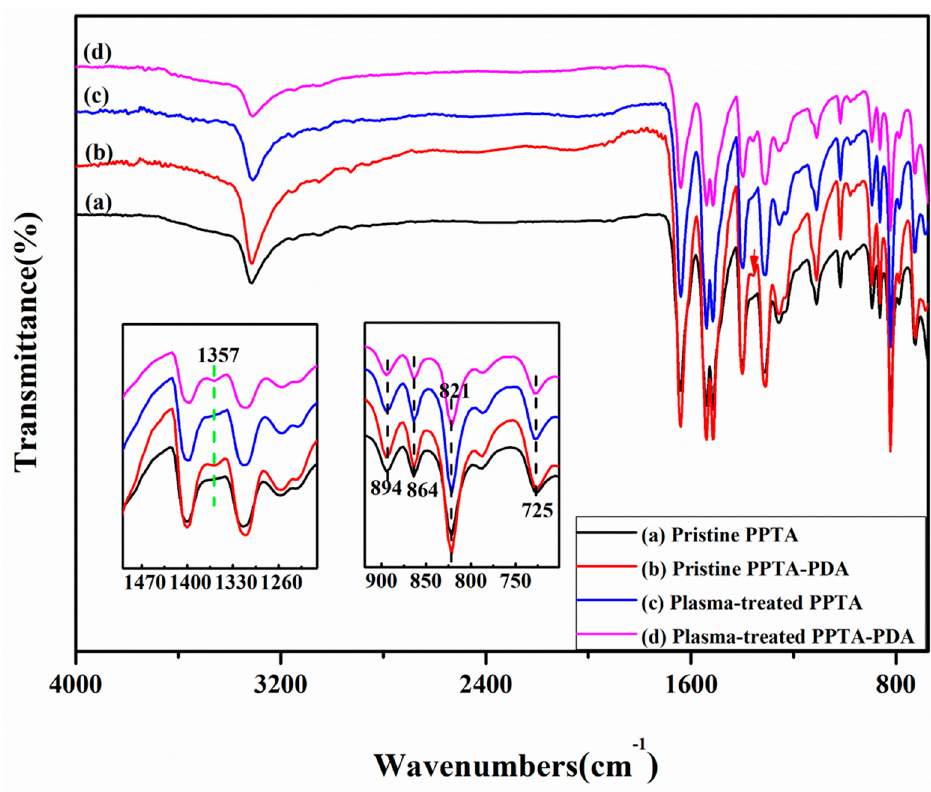
Figure 4. The attenuated total reflection Fourier transform infrared spectroscopy of ( a ) pristine PPTA fibers, ( b ) pristine PPTA–PDA fibers, ( c ) plasma-treated PPTA fibers and ( d ) plasma-treated PPTA-PDA fibers.